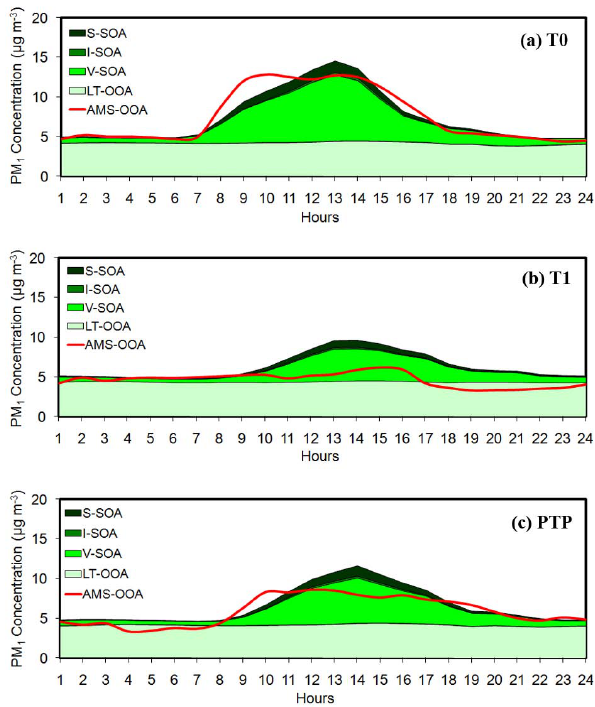
Fig. 9. Comparison of model episode average diurnal predictions for PM 1 oxygenated organic aerosols (sum of LT-OOA, V-SOA, I- SOA, and S-SOA) against AMS-OOA taken during the MILAGRO campaign in 4–30 March 2006 at (a) T0, (b) T1 and (c) PTP.